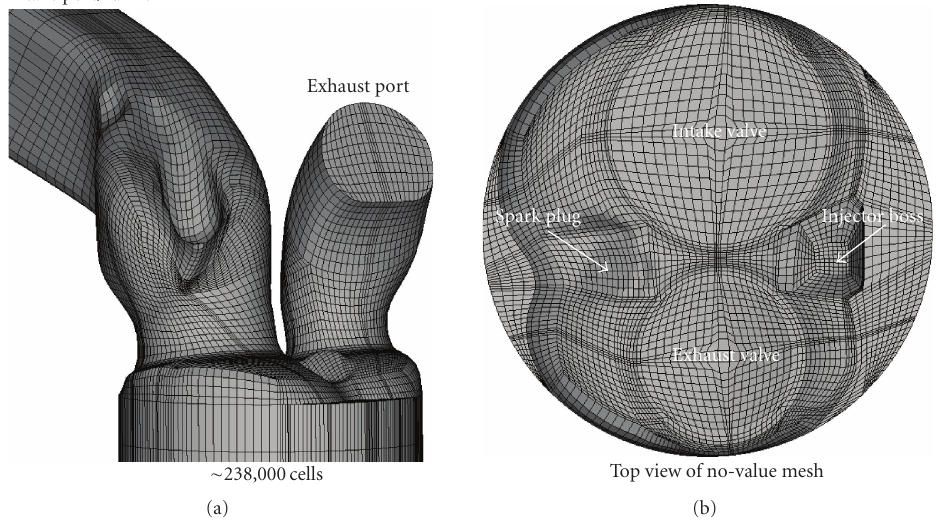
Figure 3: Computational mesh for the single cylinder homogeneous GDI engine.